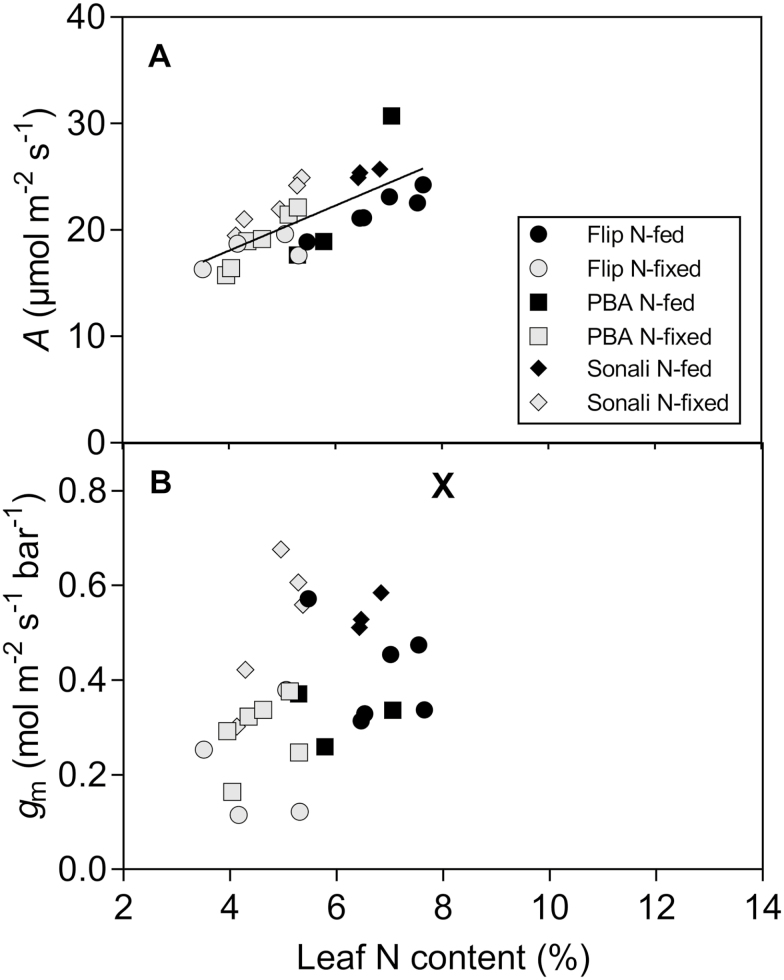
Relationships between leaf N content and photosynthetic rate (A; A) and mesophyll conductance to CO2 (gm; B), measured at 1000 µmol m−2 s−1 PPFD, for three chickpea genotypes grown under two nitrogen source treatments. The solid line in plot A indicates a significant linear regression (P < 0.001, R2 = 0.51).